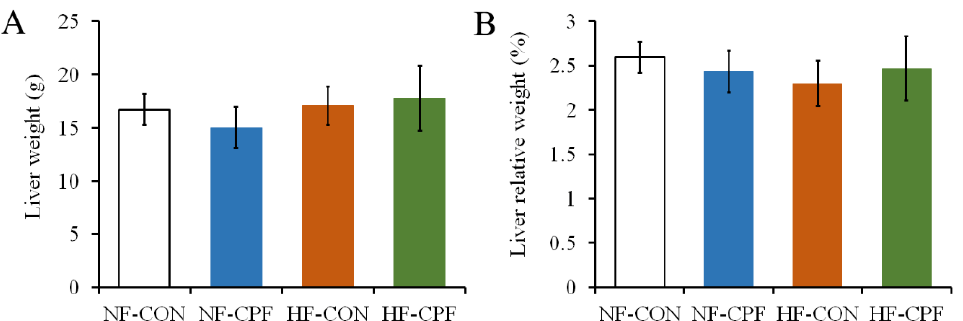
Figure 1. Effects of CPF on liver weight ( A ) and relative weight (to the whole bodyweight, ( B )) of rats treated with 3.0 mg/kg b.w. CPF under the NF diet and HF diet. CPF—Chlorpyrifos. NF-CON—fed a normal-fat diet and vehicle. NF-CPF—fed a normal-fat diet and chlorpyrifos. HF-CON—fed a high-fat diet and vehicle. HF-CPF—fed high-fat diet and chlorpyrifos. These results indicated that 3.0 mg/kg b.w. CPF exposure did not show a negative effect on liver weight in response to the NF dietary pattern or the HF dietary